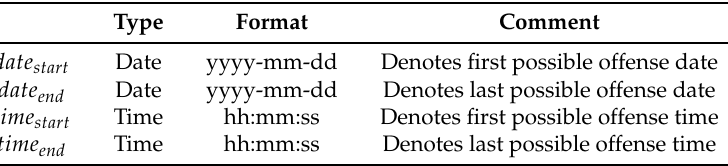
Table 2. Type and format of instances’ attributes.